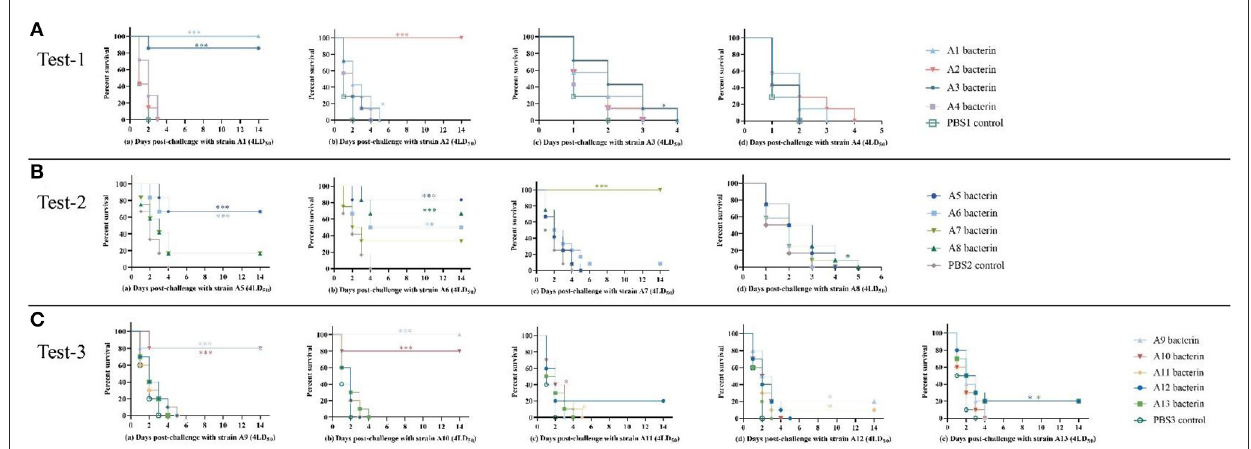
FIGURE3 Survival-time curves of mice immunized with A1–A13 bacterins when challenged with serogroup A P. multocida strains (Tests-1–3). (A) Test-1, mice were subcutaneously immunized with A1–A4 bacterins, and intraperitoneally challenged with 4LD 50 of strains A1, A2, A3, or A4 (a–d). (B) Test-2, mice immunized with A5–A8 bacterins were intraperitoneally challenged with 4LD 50 of strains A5, A6, A7, or A8 (a–d). (C) Test-3, mice immunized with A9–A13 bacterins were intraperitoneally challenged with 4LD 50 of strains A9, A10, A11, A12, or A13 (a–e). Each group was composed of 7–12 mice and survival time was monitored daily for 14 days after challenge. * P < 0.05; ** P < 0.01; *** P < 0.001, in comparison with the PBS control.